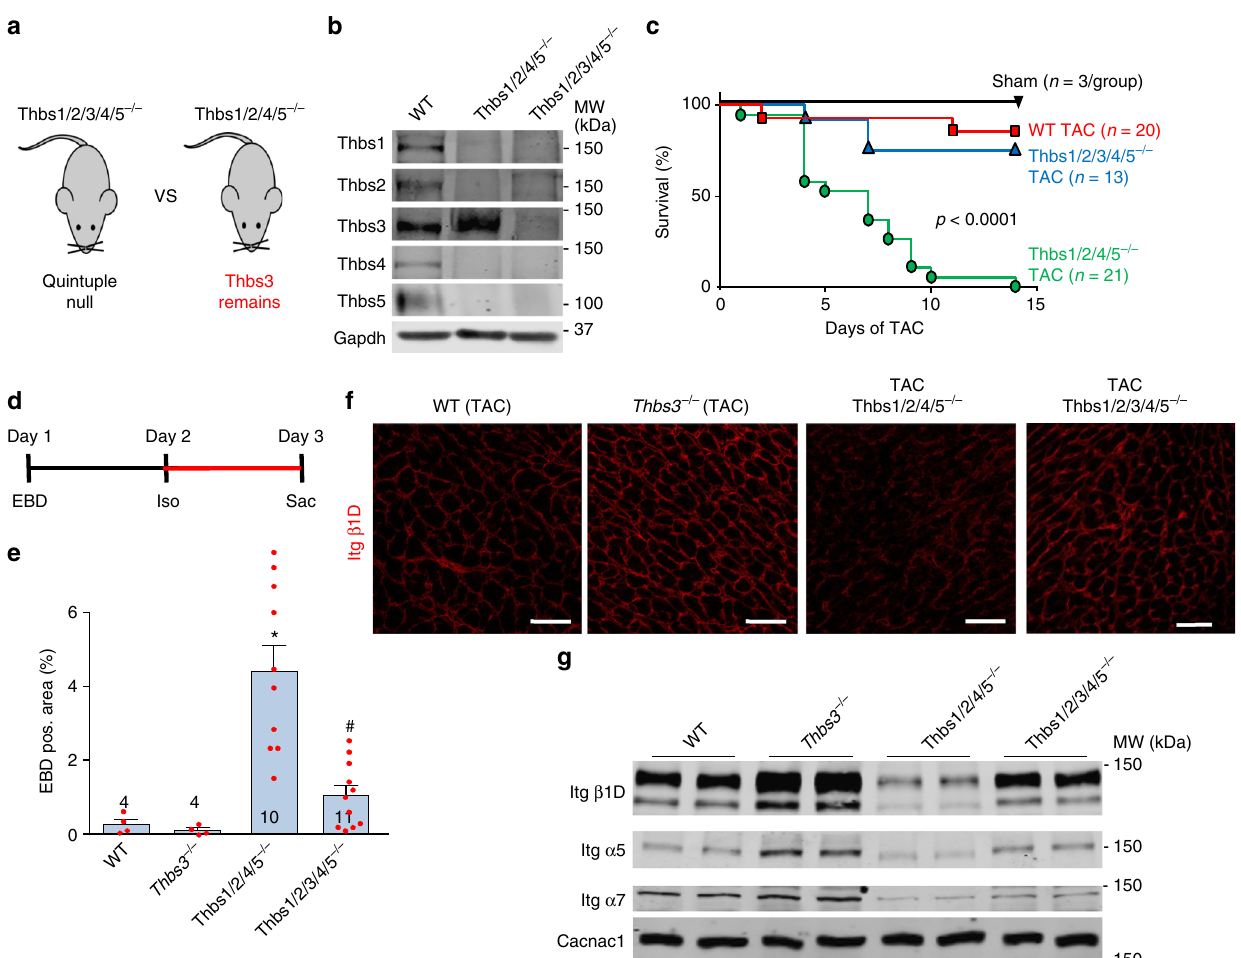
Fig. 5 Induction of endogenous Thbs3 is detrimental after cardiac injury. a Schematic diagram depicting the Thbs gene-deleted mice used to selectively analyze effects of endogenous Thbs3. b Representative Western blots from hearts of 1 – 3 day-old WT, Thbs1/2/3/4/5 − / − and Thbs1/2/4/5 − / − mice for the indicated Thbs proteins. Gapdh served as loading control. c Kaplan – Meier survival plot of shams, WT, Thbs1/2/3/4/5 − / − and Thbs1/2/4/5 − / − mice after TAC surgery in days. Number of mice used is shown in the graph for each group. P < 0.0001 analyzed by log-rank test WT versus Thbs1/2/ 4/5 − / − and Thbs1/2/3/4/5 − / − versus Thbs1/2/4/5 − / − . d Experimental regimen of EBD and Iso injection into the groups of mice shown ( e ) to measure membrane permeability. e Quanti fi cation of EBD positive area in the hearts of the indicated groups of mice after Iso injection with the regimen shown in d . * P < 0.05 versus WT; # P < 0.05 versus Thbs1/2/4/5 − / − mice. Statistical analysis was performed using one-way ANOVA and Turkey multiple comparisons test. Error bars are + / − standard error of the mean and number of mice used in each experiment are shown in the graphs. f Immunohistochemistry for β 1D integrin from heart sections of WT, Thbs3 − / − , Thbs1/2/4/5 − / − and Thbs1/2/3/4/5 − / − mice 1 week after TAC surgery. Scale bars are 50 μ m. g Representative Western blots for the indicated integrin proteins from hearts of WT, Thbs3 − / − , Thbs1/2/4/5 − / − , and Thbs1/2/3/4/5 − / − mice subject to 1 week of TAC and processed for sarcolemma protein extracts. Cacna1c served as loading control. Quantitation of these results is shown in